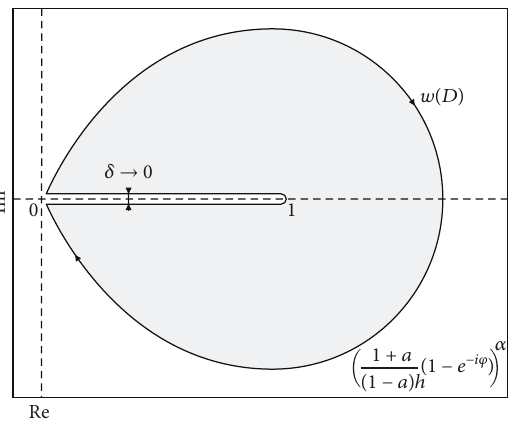
Figure 2: Contour of w D